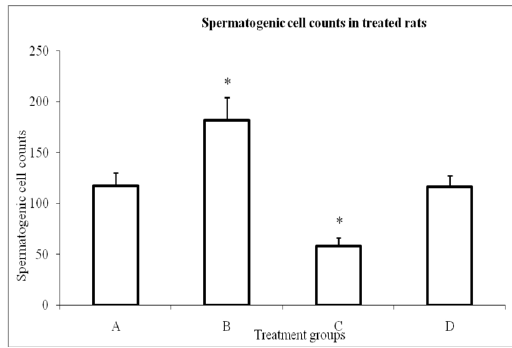
*p < 0.05 as compared to group A (control) *p < 0.05 as compared to group D (EL + estradiol) Figure 2 - Spermatogenic sperm counts. The values are shown as the mean + standard deviation. Group B (EL treated) shows a marked increase in the spermatogenic cell count, compared to group A (control) and group D (EL + estradiol). The sperm count is significantly reduced in group C (estradiol- treated rats) compared to group A and group D